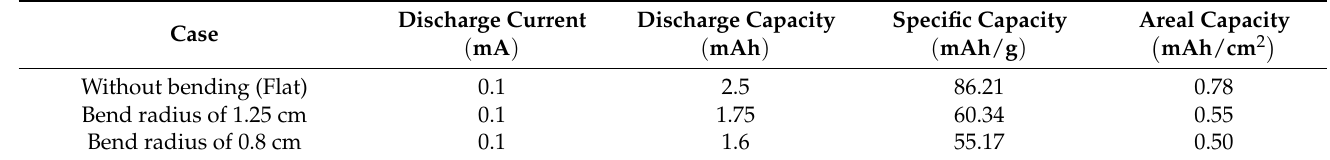
Table 1. Illustration of battery capacities with reference to the active mass and the electrode area for different test